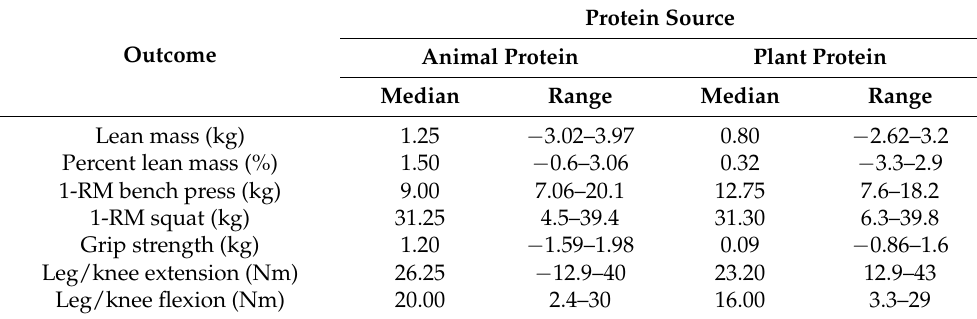
Table 3. Summary of changes in lean mass and strength from baseline levels after the consumption of animal protein compared to plant protein